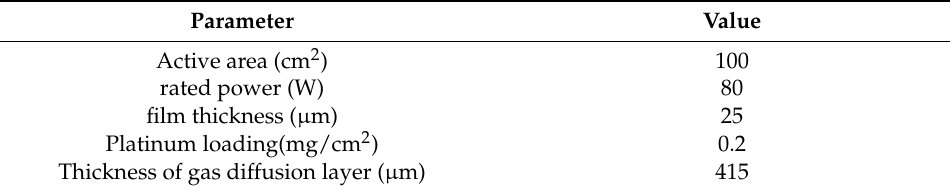
Figure 1. Physical graph of proton exchange membrane fuel cell (PEMFC) test system. Table 1. Key parameters of the PEMFC stack.